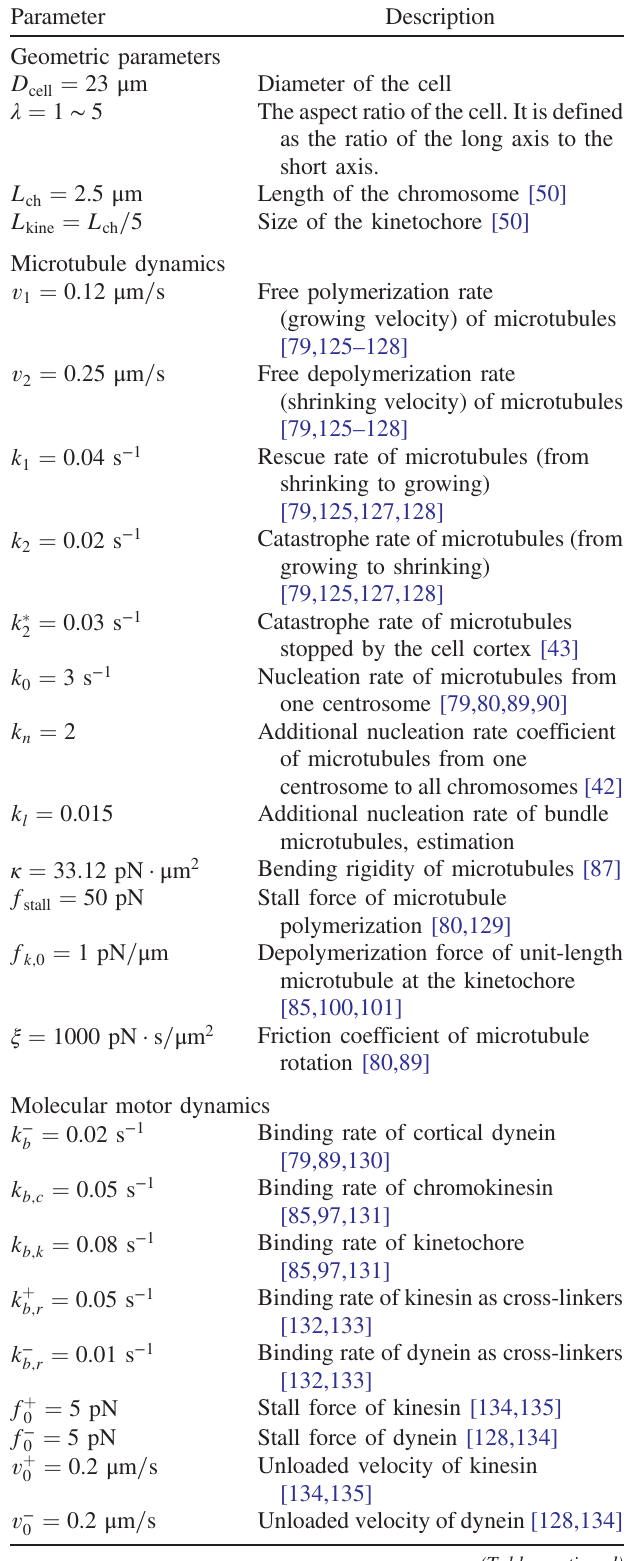
TABLE I. Parameters used in the